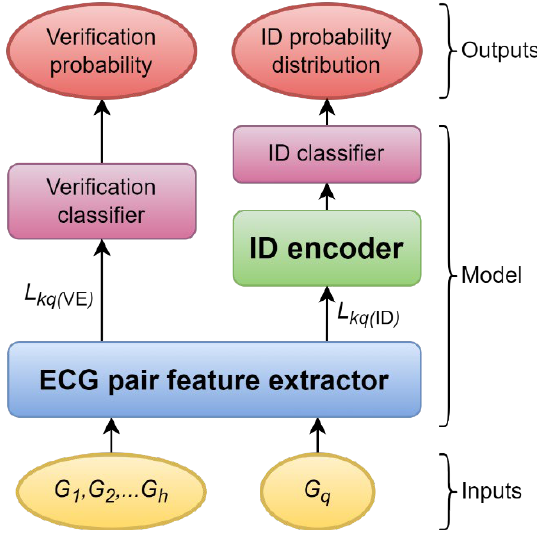
Figure 1. An overview of the model design.